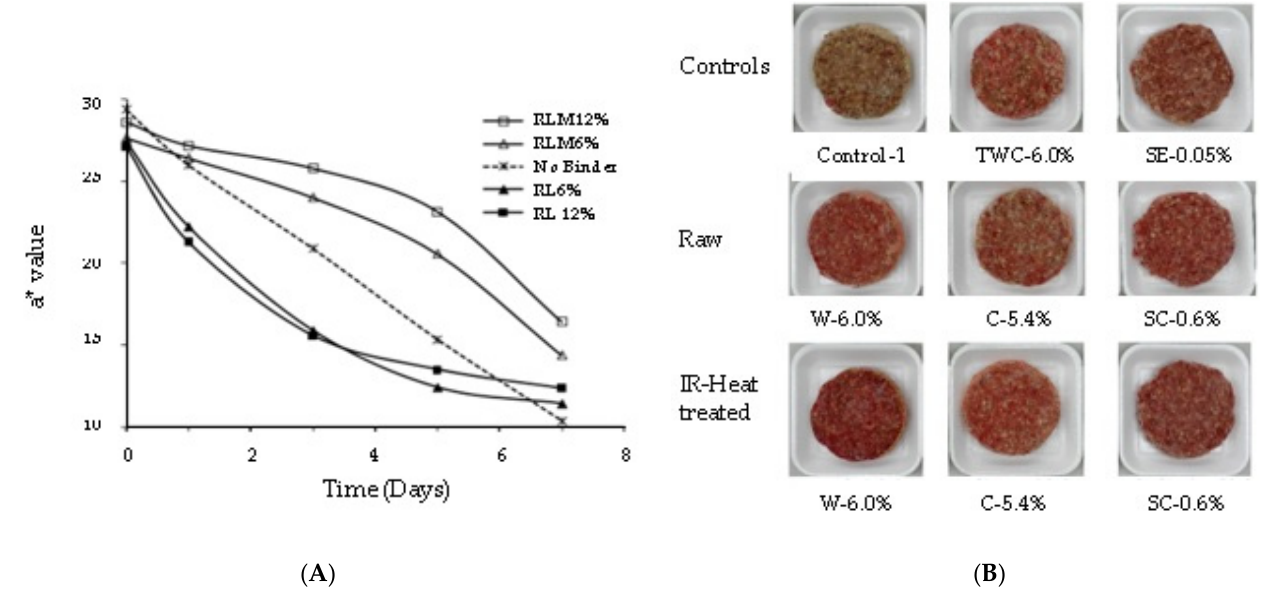
Figure 4. ( A ) Change in HunterLab a* values of raw beef burgers containing dehulled red lentil flour and stored at 4 °C from 0 to 7 days (RLM = red lentil IR-treated; RL = red lentil non-IR-treated). (Reprinted with permission from Der [16]). ( B ) Color of uncooked beef burgers formulated with green lentil cotyledon flour and hull fiber after a 12-week frozen storage at − 18 °C (Control-1: no binder, TWC = toasted wheat crumb, SE = sodium erythrobate, W = whole seed flour, C = cotyledon flour, SC = hull fiber (Adapted with permission from Li [18]).